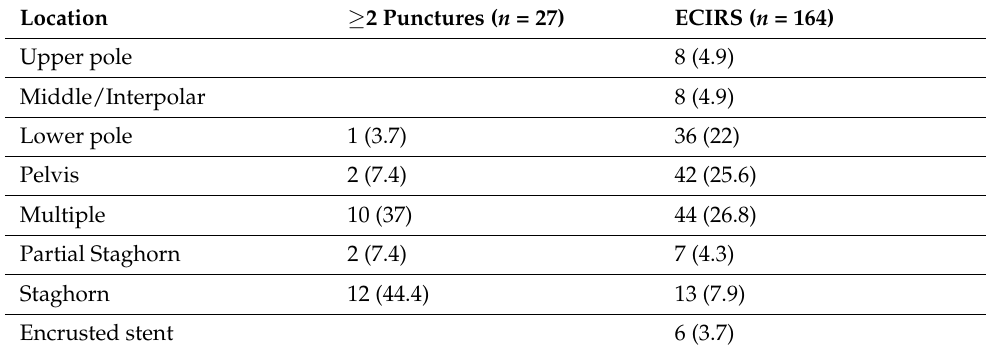
Table 2. Number of punctures stratified by stone position.